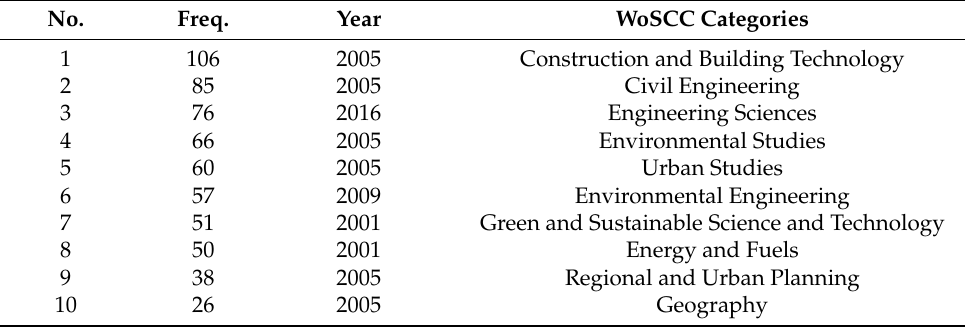
Table 6. Major high-density city research categories from 2001 to 2022. No.